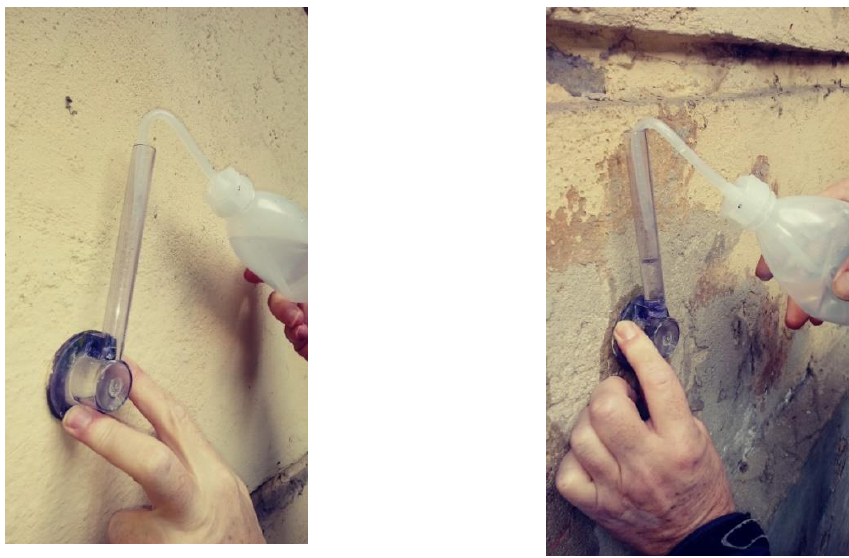
Figure 7. External wall layer water absorptivity testing.